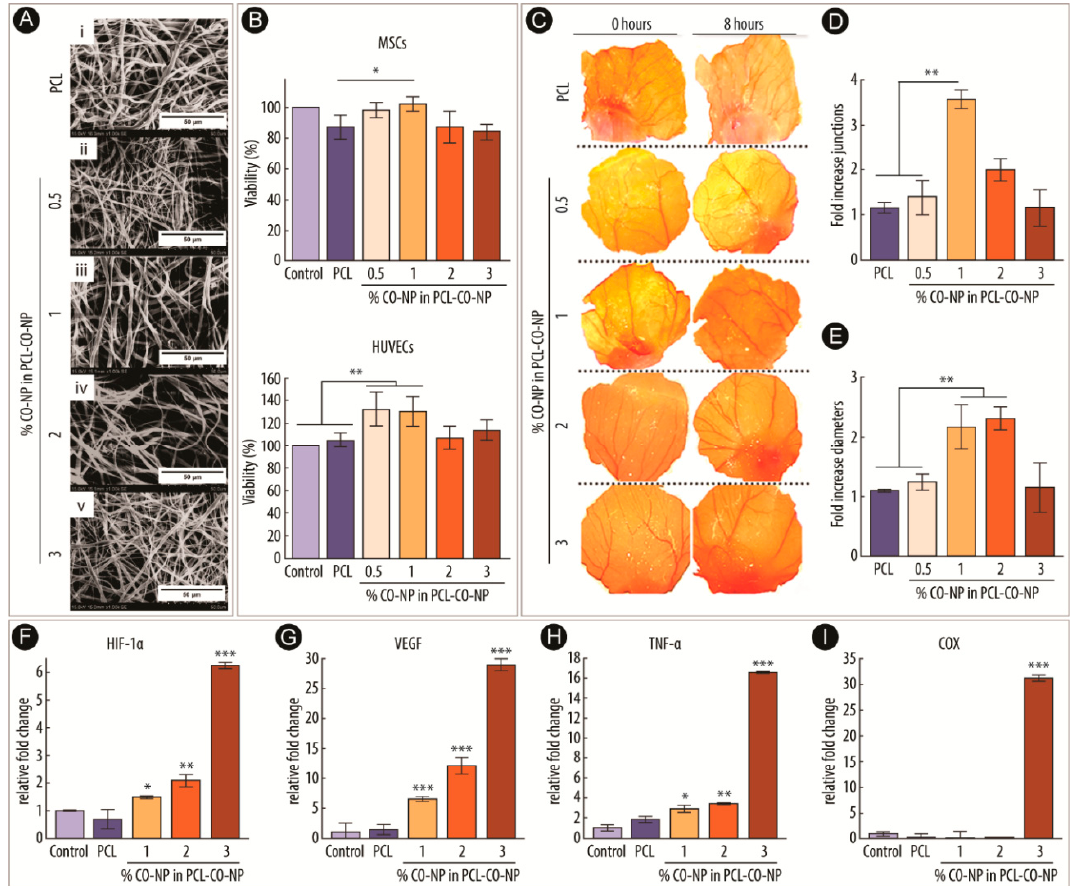
Figure 3. Cerium-oxide nanoparticles (CO-NPs) used for angiogenesis in tissue engineering scaffolds. SEM images of electrospun polycaprolactone (PCL) scaffolds, with different ratios of CO-NPs incorporated (%, w / w ) ( A ). Cell viability of mesenchymal stem cells (MSCs) and human umbilical vein endothelial cells (HUVECs) on the different scaffolds ( B ). Angiogenesis assay using the chick chorioallantoic membrane (CAM) model incubated with PCL and PCL-CO-NP scaffolds after 0 and 8 h ( C ). Corresponding blood vessel junctions ( D ) and diameter of blood vessel fold increase ( E ). Expression of hypoxia-inducing factor 1 α (HIF-1 α ) ( F ), vascular endothelial growth factor (VEGF) ( G ), tumor necrosis factor α (TNF- α ) ( H ), and cyclooxygenase (COX) ( I ) in tissues isolated from implanted scaffolds; * p < 0.05, ** p < 0.001, *** p < 0.0001 vs. control. Reprinted with permission from Reference